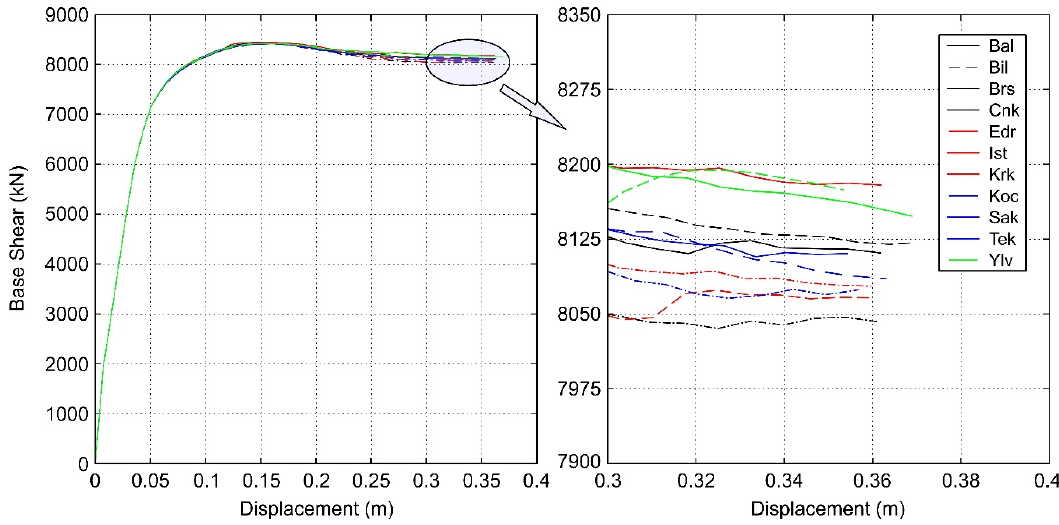
Figure 12. Comparison of pushover curves for 3-story.